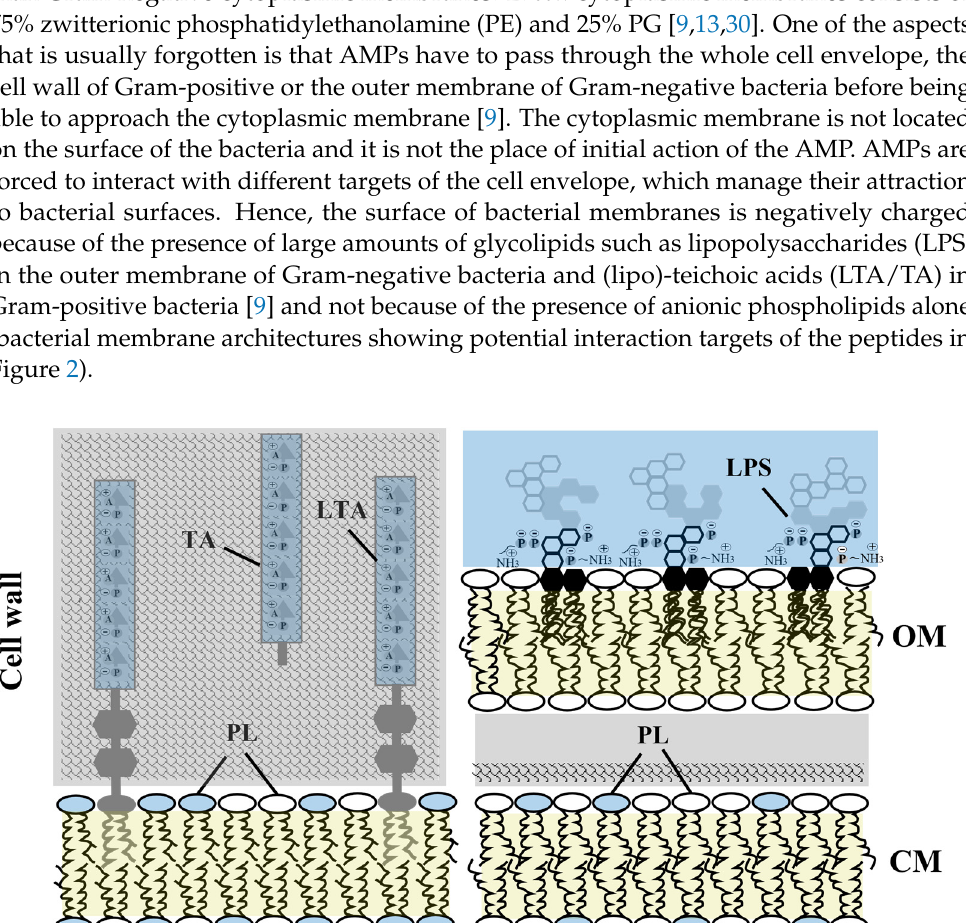
Figure 2. Cell envelopes of Gram-negative and Gram-positive bacteria. Negatively charged lipids distributed across the outer membrane (OM) and cytoplasmic membrane (CM) are shown in blue.